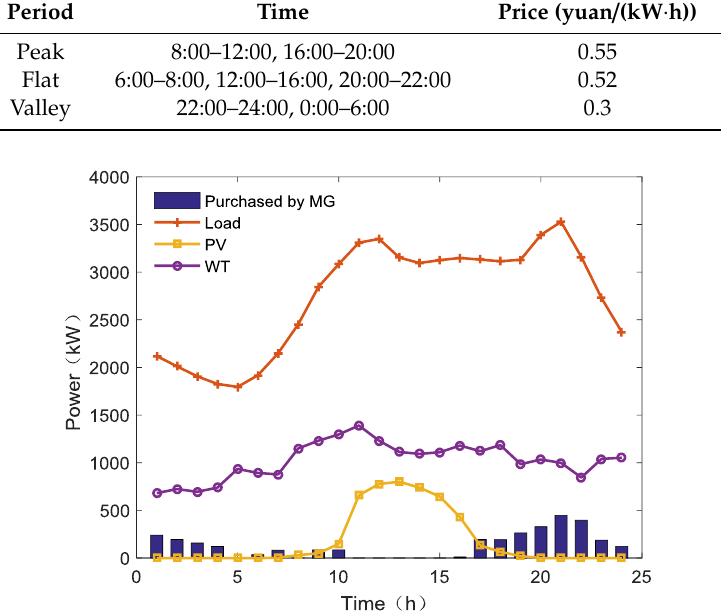
Figure 2. The power of load, wind turbine, photovoltaic output and purchased power by microgrid.